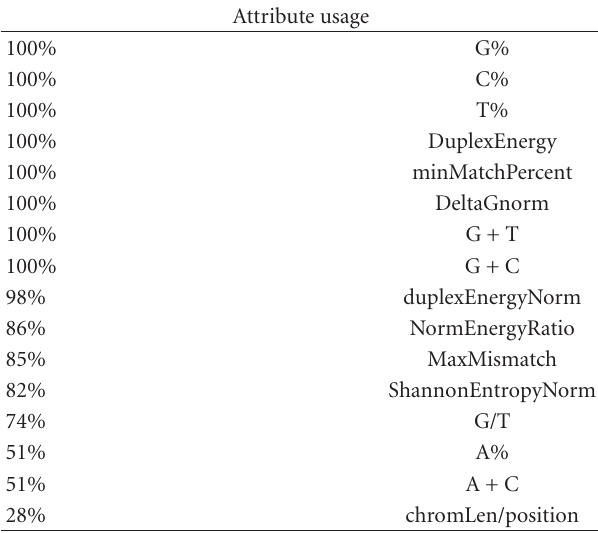
Table 5: Example of attribute usage from one representative train- ing run.